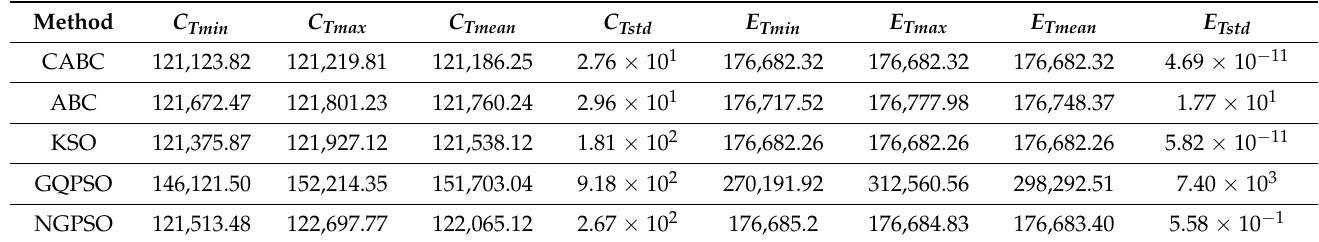
Table 3. Statistical results (Case